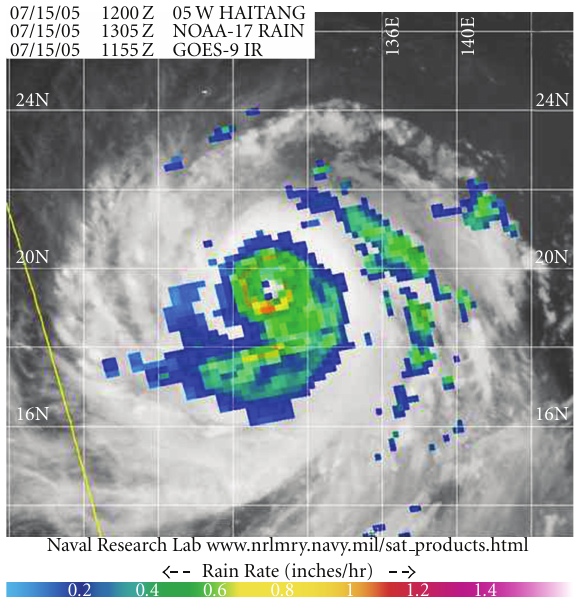
Figure 14: Advanced Microwave Sounding Unit-B (AMSUB)- sensor observed rain at 1305 UTC on 15 July 2005 (color shading) superimposed on the GOES-9 IR image obtained at 1155 UTC on 15 July 2005 (gray shading) (from http://www.nrlmry.navy.mil/tc pages/tc